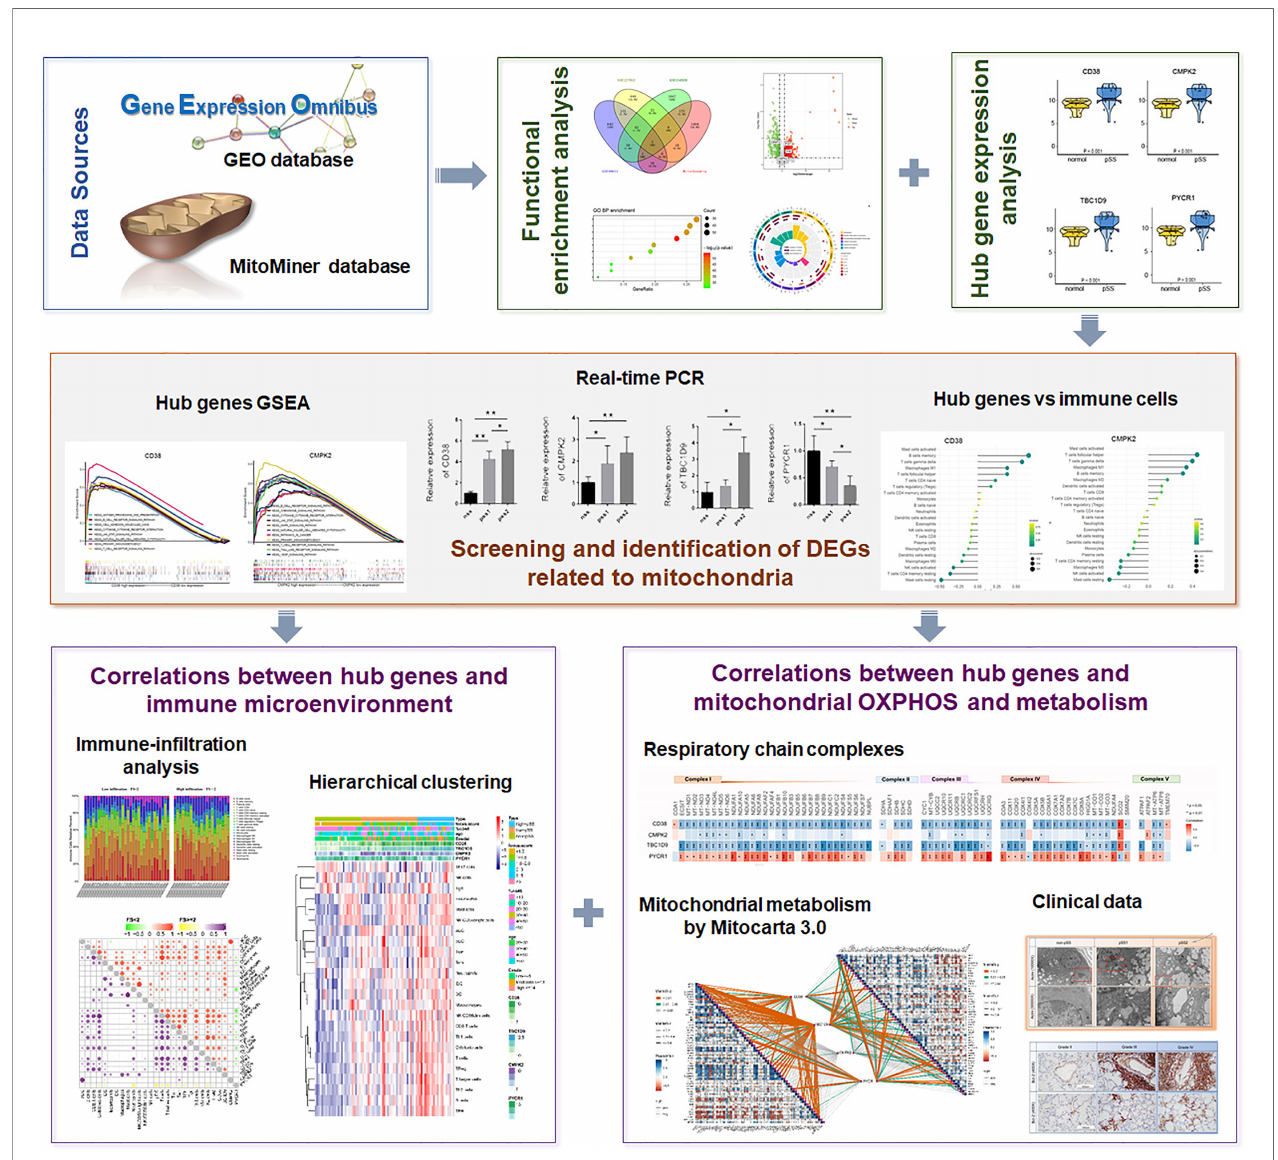
FIGURE 1 | The illustrations for this study. The overall protocol utilized in the current study to construct a network between mitochondria and immune microenvironment in primary Sjogren ’ s syndrome